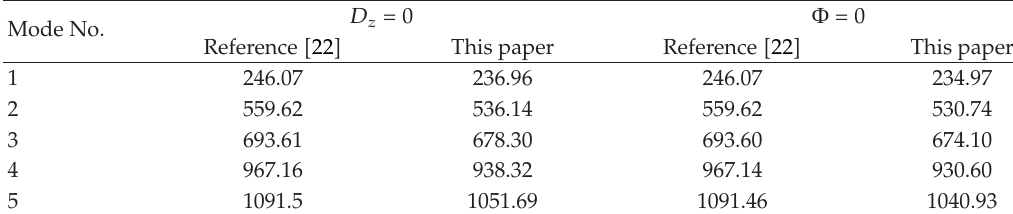
Table 4: Nondimensional frequencies (cid:3) ωa 2 ρ 1 / 2 / 2000 πh (cid:6) of a simple supported square plate with di ff erent potential boundary